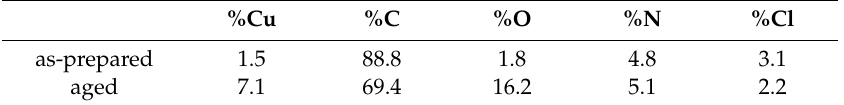
Table 1. XPS surface elemental composition of CuNPs@BAC samples as prepared and aged for 29 days. The error in the atomic percentages is 0.2% for copper, 0.5% for all the other elements.